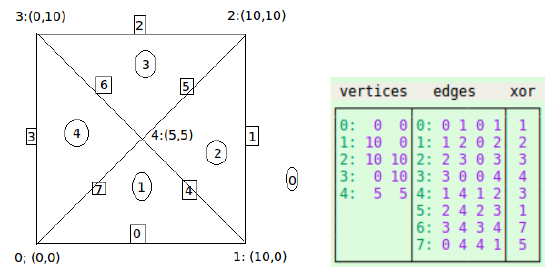
Fig. 7: Two-dimensional vector input dataset: graphical representation (left) and the necessary data structure (right).